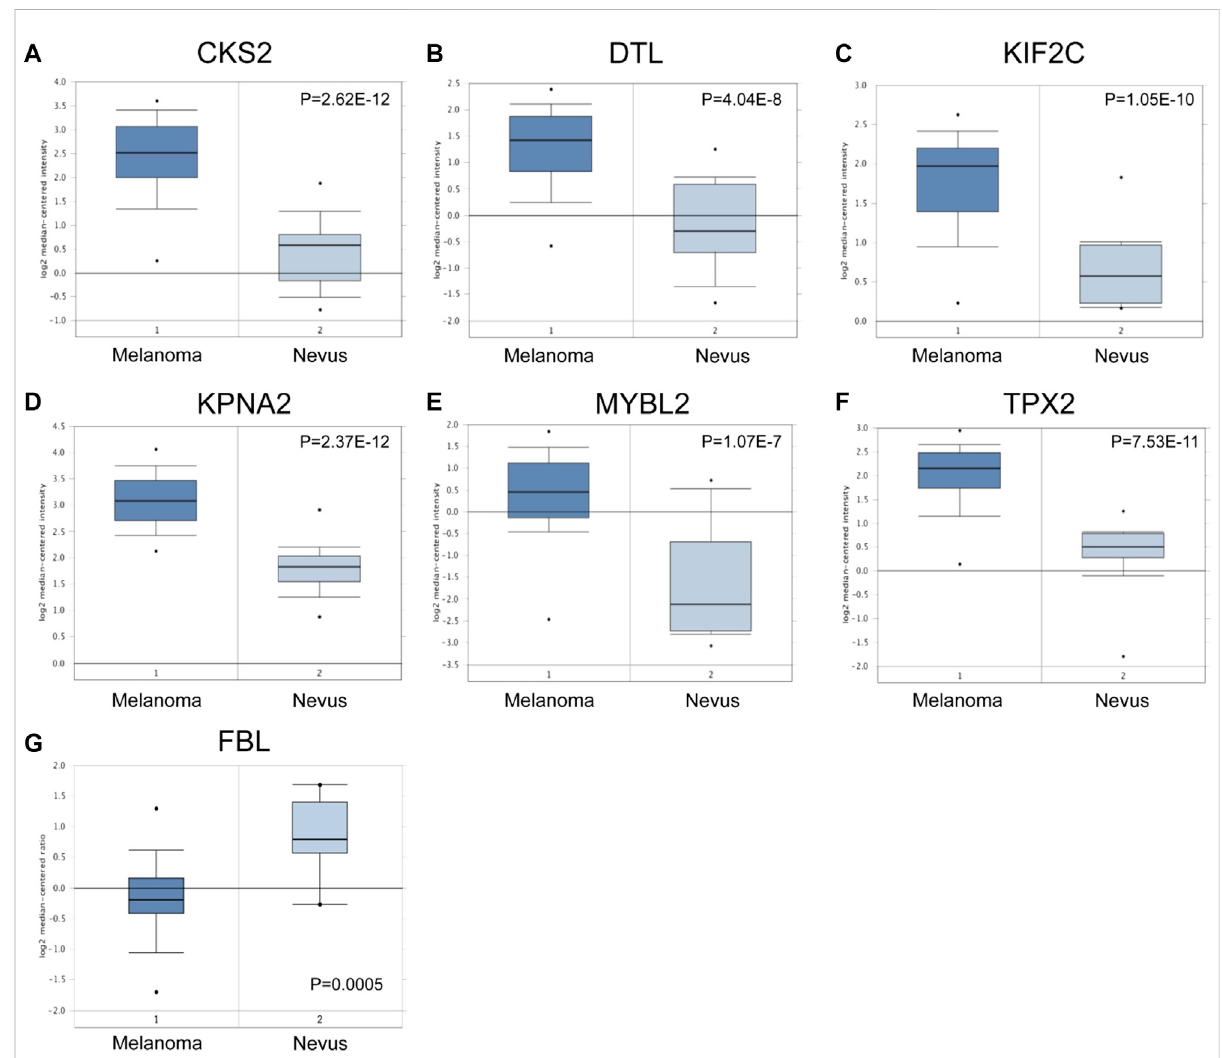
FIGURE 6 Validation of the expression of hub genes in Oncomine database. Theexpression level of CKS2, DTL, KIF2C, KPNA2, MYBL2, TPX2 and FBL was detected in Oncomine